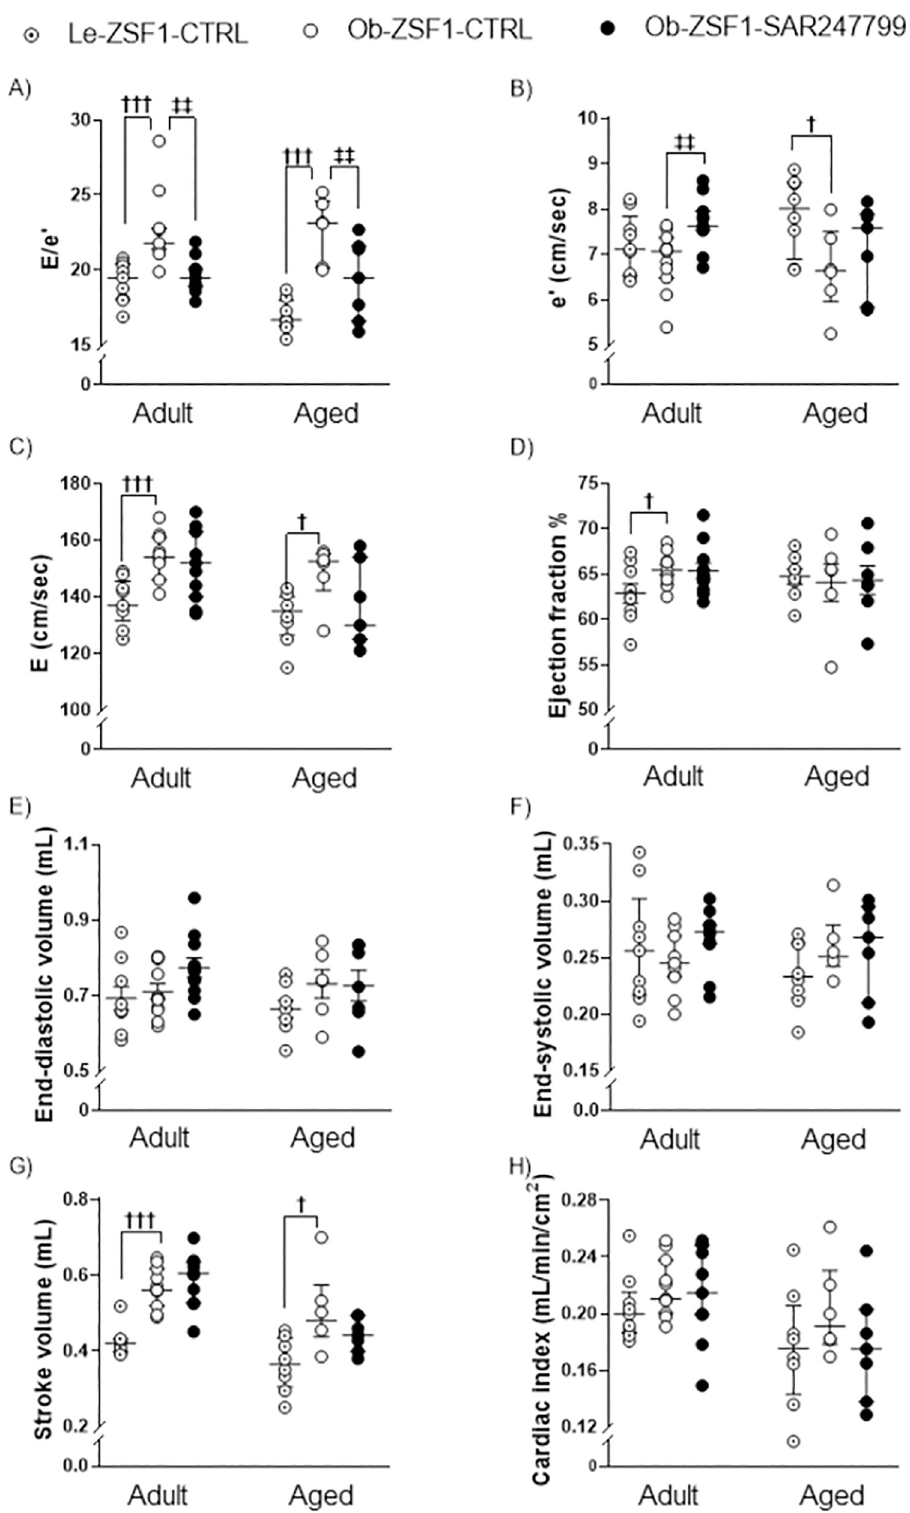
Fig 2. Cardiac diastolic and systolic function in adult and aged ZSF1 rats after 4 weeks of treatment. Diastolic function was evaluated by (A) E/e’ ratio (B) septal peak e’ wave velocity at mitral annulus level and (C) mitral valve peak E wave velocity. Cardiac systolic function was assessed by (D) ejection fraction, (E) end-diastolic volume, (F) end-